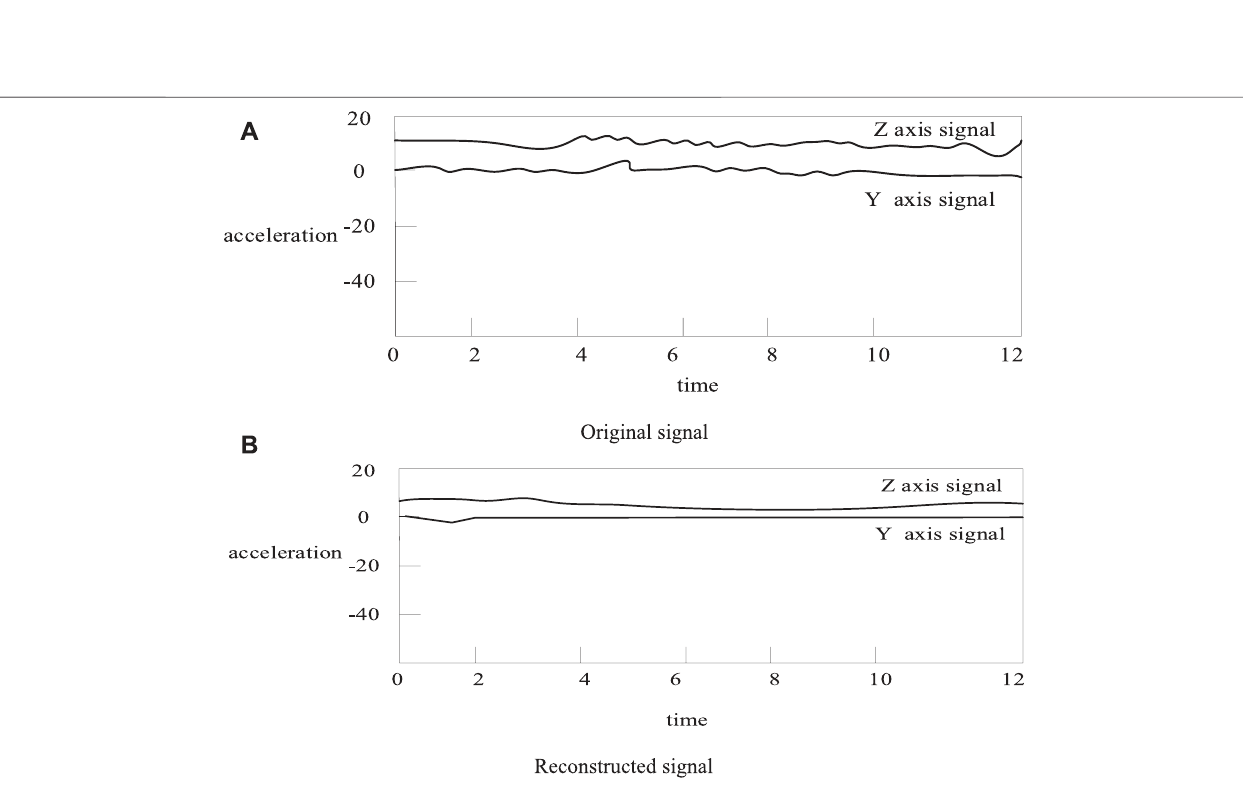
Frontiers in Bioengineering and Biotechnology |